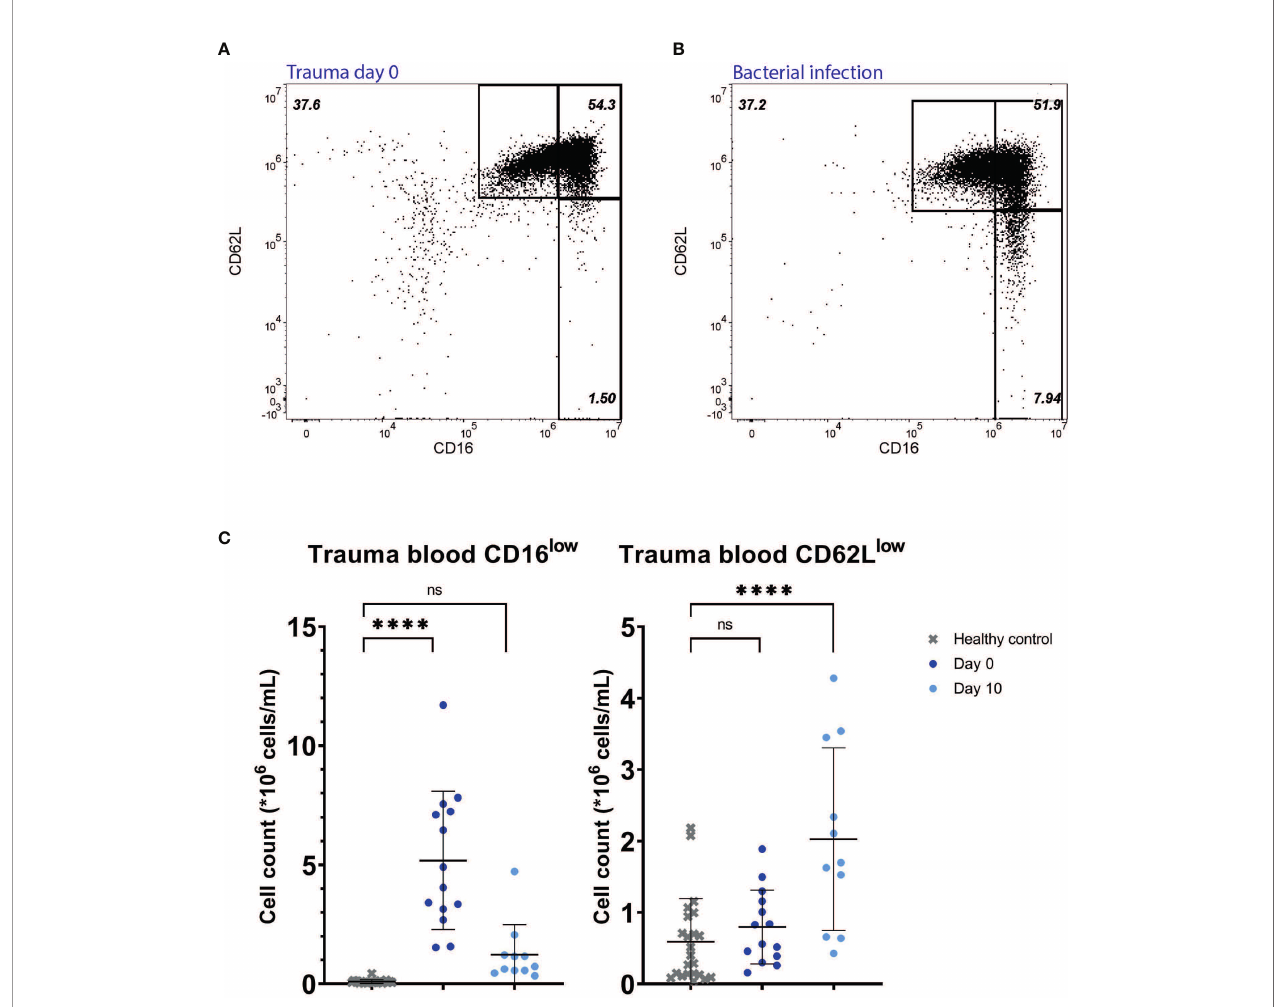
FIGURE 2 | Multitrauma patients. Representative FACS examples of CD16/CD62L plot of blood from a multitrauma patient right after admission (day 0) (A) , and from a patient suffering from a bacterial infection at the fi rst day of symptoms (B) . Cell counts of CD16 low neutrophils (left panel) and CD62L low neutrophils (right panel) in healthy control (HC) blood (n=23) and in blood from trauma patients at day 0 (n=14) and day 10 (n=11) (C) . Lines are means with SD. A one-way ANOVA analysis (unpaired) with a post-hoc Dunnett ’ s multiple comparisons test was used to test signi fi cance. Signi fi cance is displayed in graphs as ns, not signi fi cant or P****